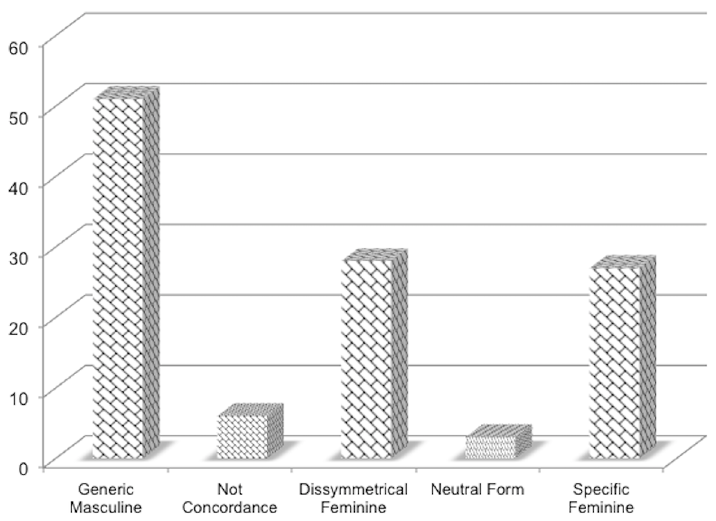
Figure 2. Sexist/non-sexist language by each modality. Frequencies